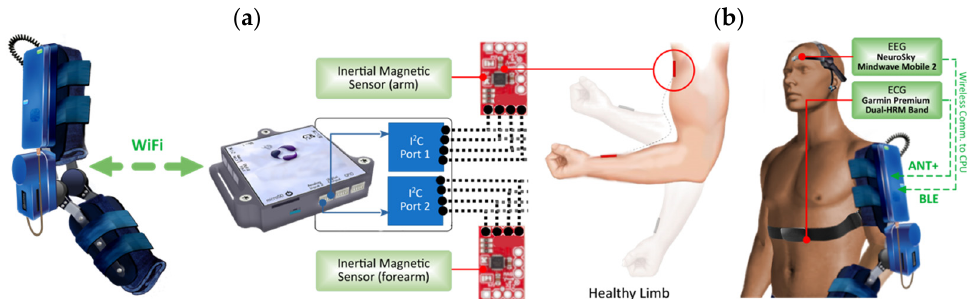
Figure 6. Sensors external to the robotic exoskeleton, wireless protocols. Part ( a ) shows the commu- nication between the exoskeleton and the motion capture system. Part ( b ) shows the connection between the exoskeleton, the EEG, and ECG external sensors.